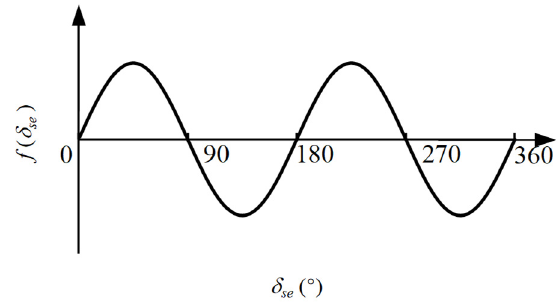
Figure 4. Error function of the stator windings position.